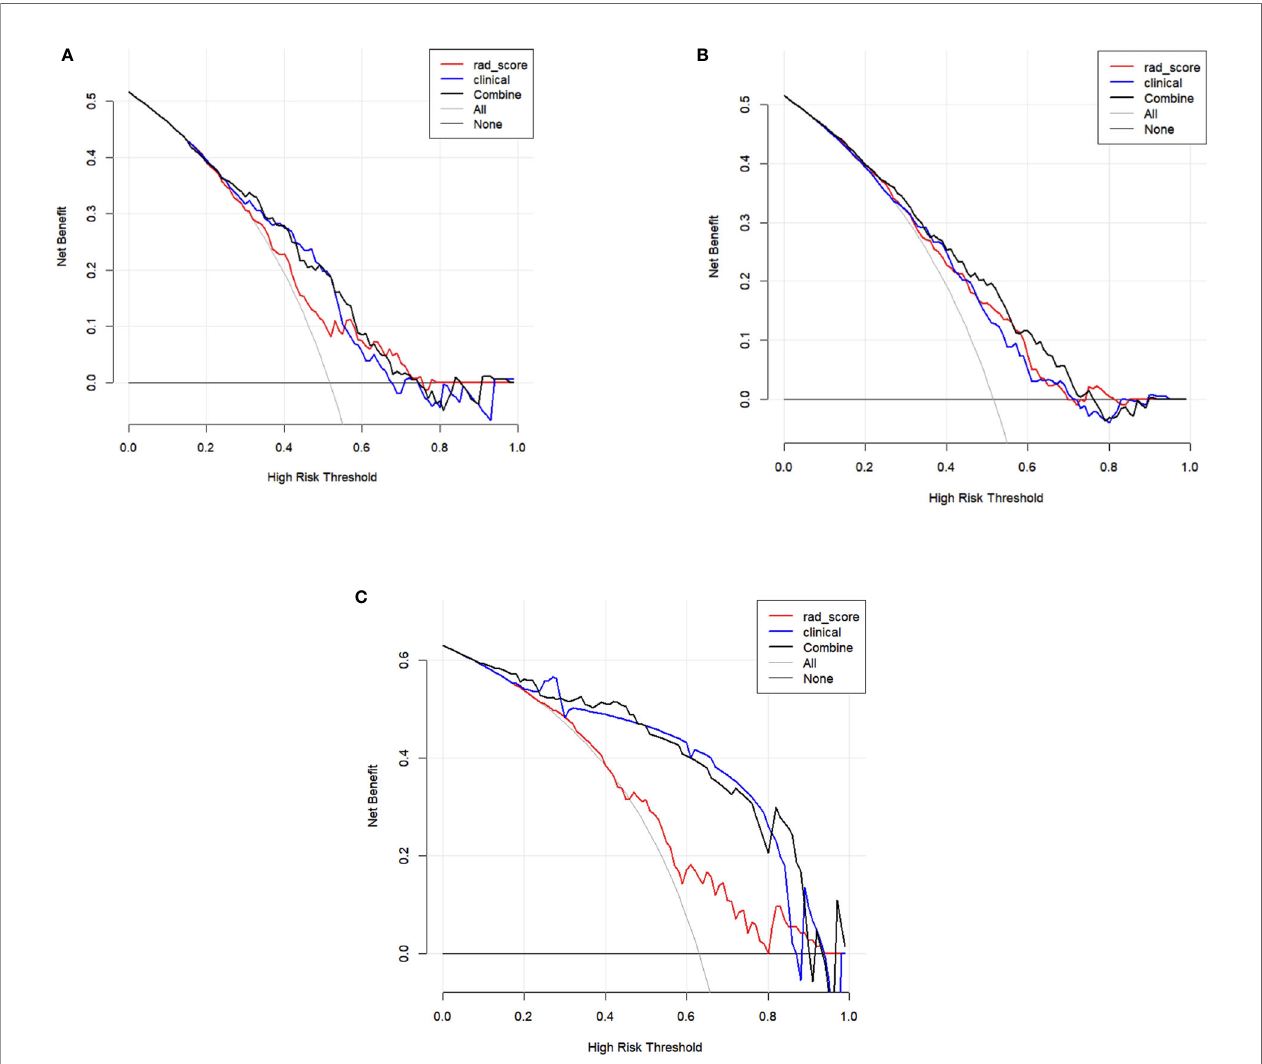
FIGURE 7 | Decision curve analysis (DCA) of training set (A) , internal test set (B) , and external test set (C) . The y-axis measures the net bene fi t. The x-axis shows the corresponding risk threshold. The grey line represents the assumption that all lesions were central lymph node metastases. The black straight line represents the assumption that all nodules were non-CLNM. If the threshold probability was more than 30%, using the combined model (black line) to predict CLNM added more bene fi t than the Rad-score model (red line) and clinical model (blue line) in the internal test set; If the threshold probability was more than 10%, using the combined model (black line) to predict CLNM added more bene fi t than the Rad-score model (red line) and clinical model (blue line) in the external test